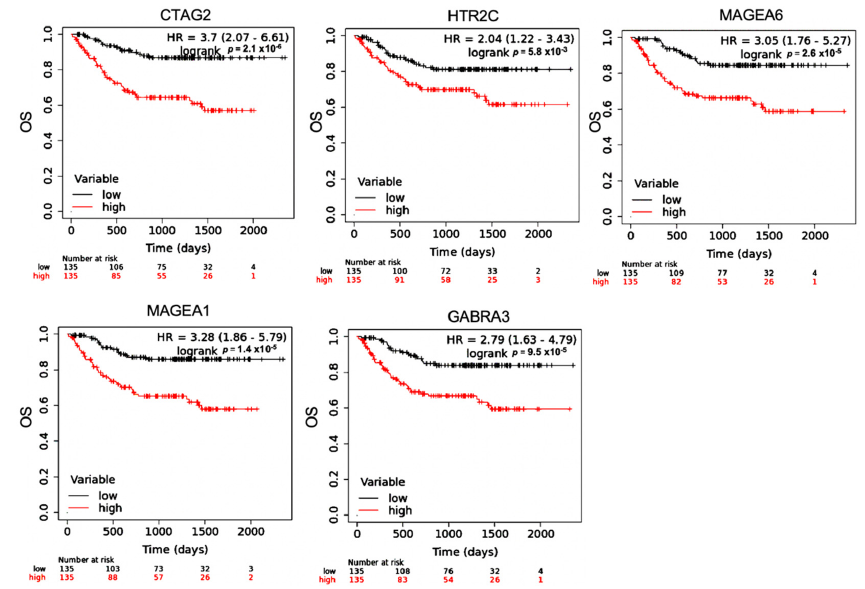
Figure 7. Overall survival of differentially expressed hub genes with p -values < 0.05, kME > 0.7 and Log Fold Change (LFC) ≥ 0.5 from the M20 module ( CTAG2 , GABRA3 , MAGEA1 , MAGEA6 , and HTR2C ) were analyzed using KMplotter. The patient samples were split based on the median ex- pression. The red lines denote samples with high gene expression, and the black lines refers to sam- ples with low expression. Hazard ratios (HR) are reported for low expression of the genes.